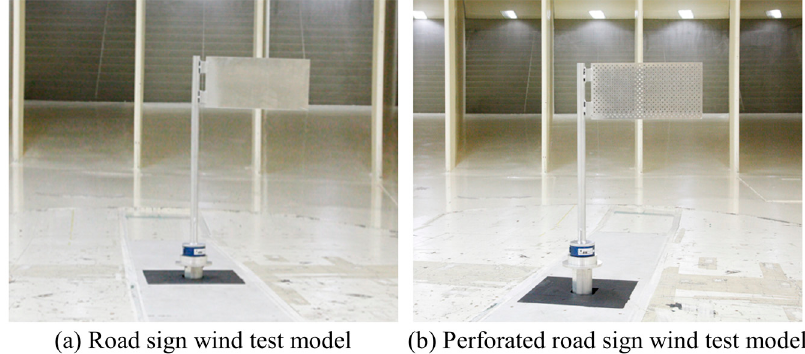
Figure 5. Wind tunnel test of perforated road sign. Table 4. Drag coefficient reduction ratio of perforated road sign.